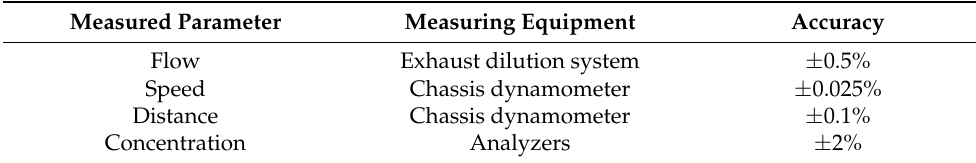
Table 5. Accuracy of the measuring equipment.